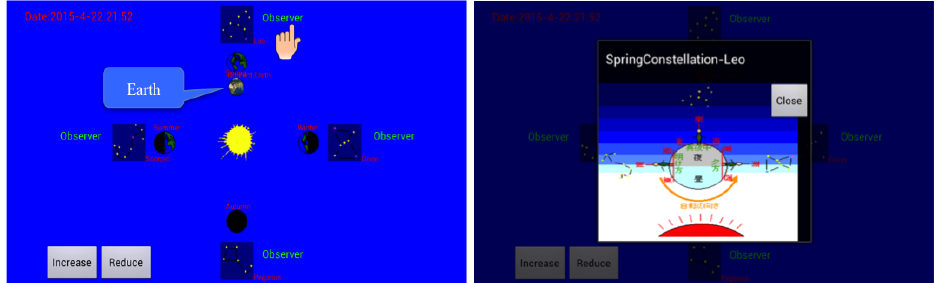
Figure 9. Clicking observer text ( left ), images of the mechanism of spring constellation–Leo ( right